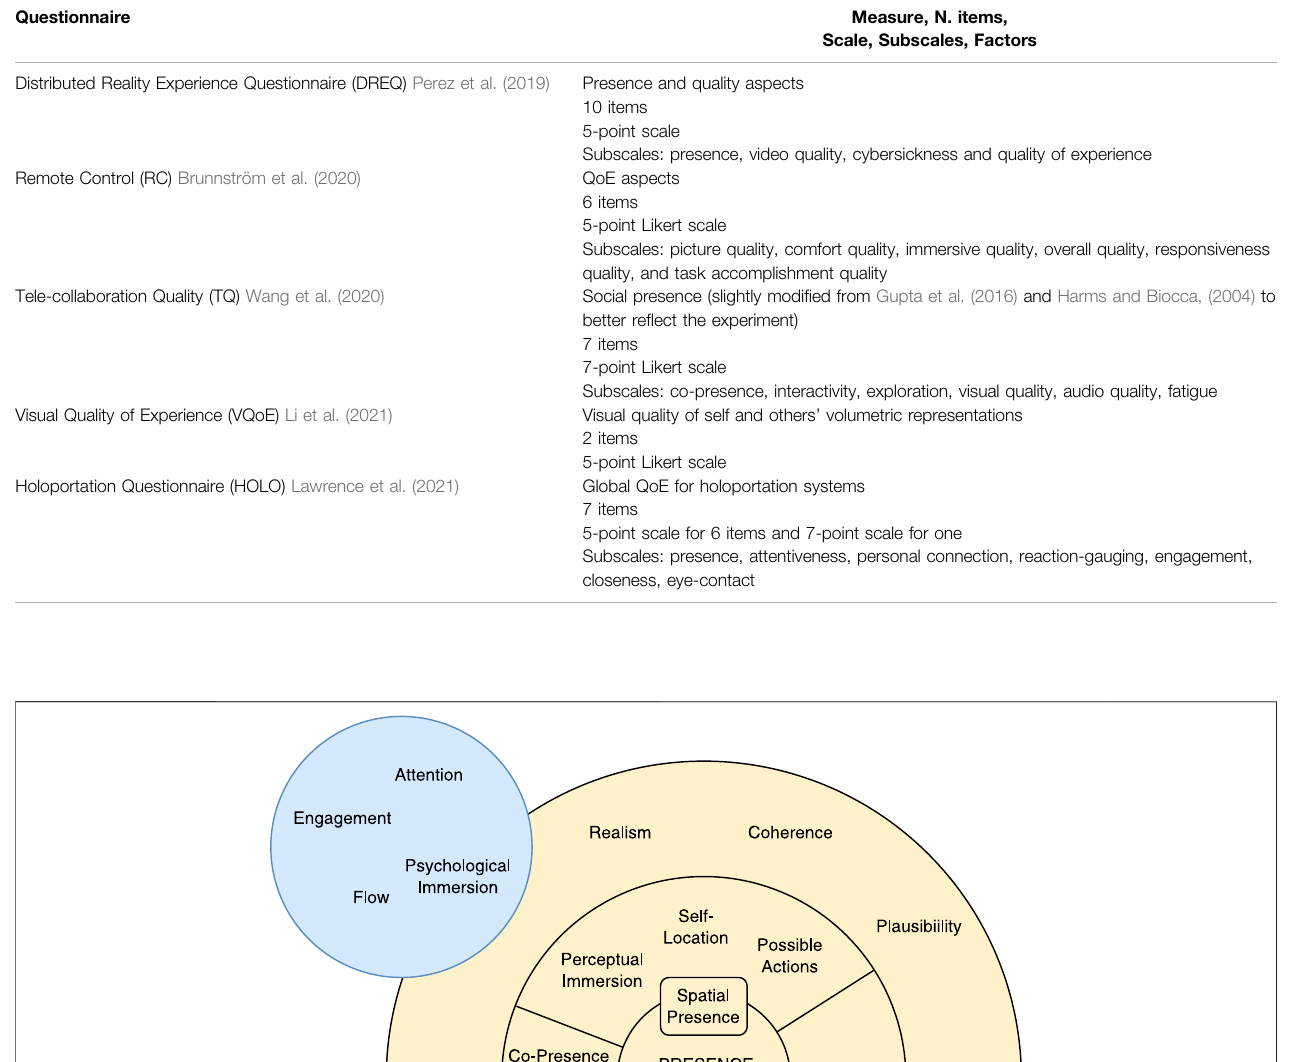
TABLE 4 | ( Continued ) Description of common questionnaires used in immersive communication experiments. Questionnaire Measure, N. items,